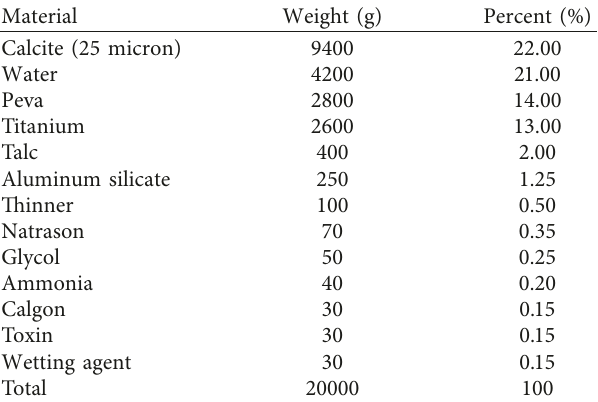
Table 3: The weights and ratios of the coating